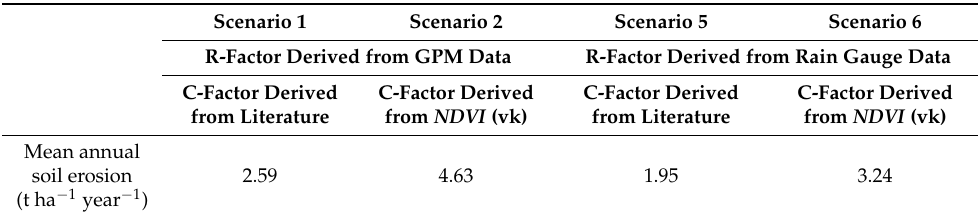
Table 10. Mean annual soil loss rates for scenarios 1, 2, 5, and